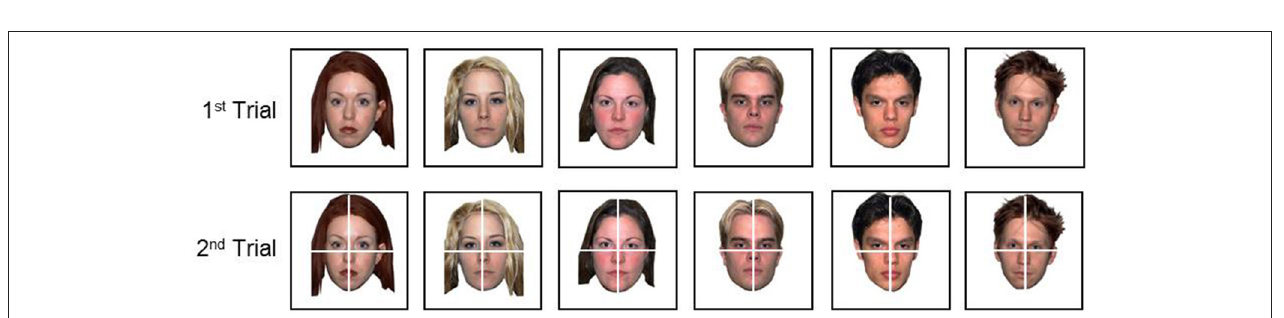
FIGURE 6 | Six TAG-Game A -HF items. If one does not successfully assemble the blocks correctly to match the face in the first trial, the second trial shows thin grid lines to separate the image segments. C play A = 22.92 for all items.